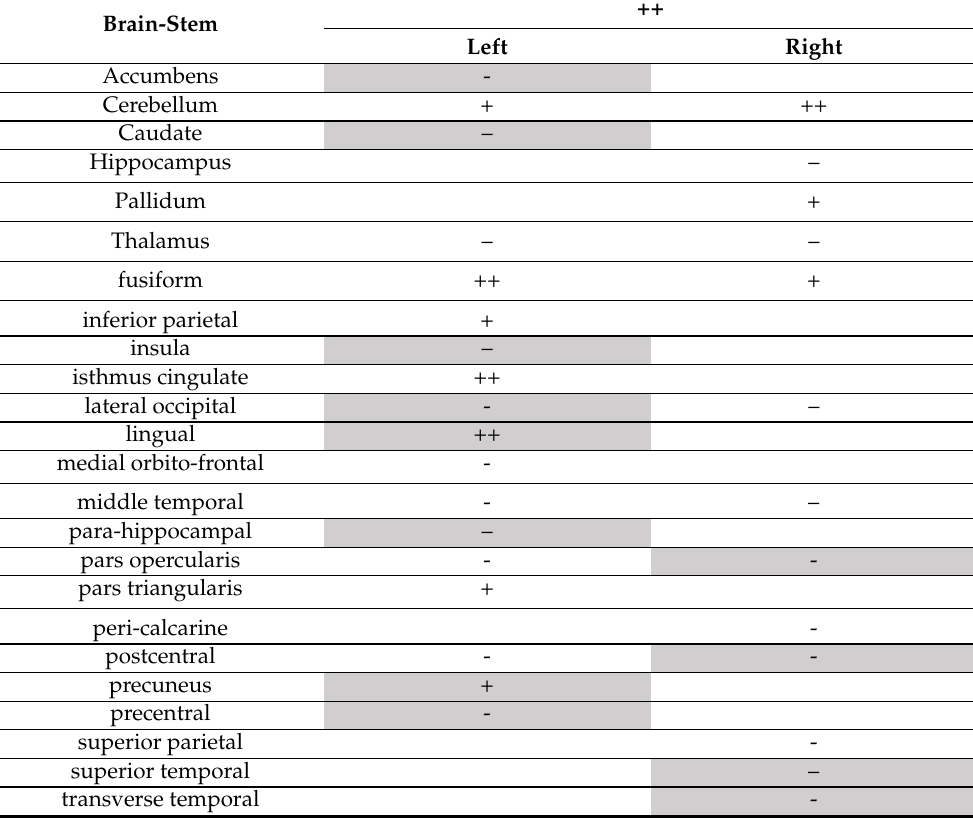
Table 6. The regions whose neuroelectric activity values contributed to the cohort-specific classifiers reported in Table 5 are shown. Activity in regions marked “+” was higher in the Team-TBI cohort; those marked “-” were lower. Regions marked “++” or “–” made the largest statistical contribution to the classifier. The results for the 2nd step are highlighted in gray. These were obtained when the regions which were selected for the first classification analysis were